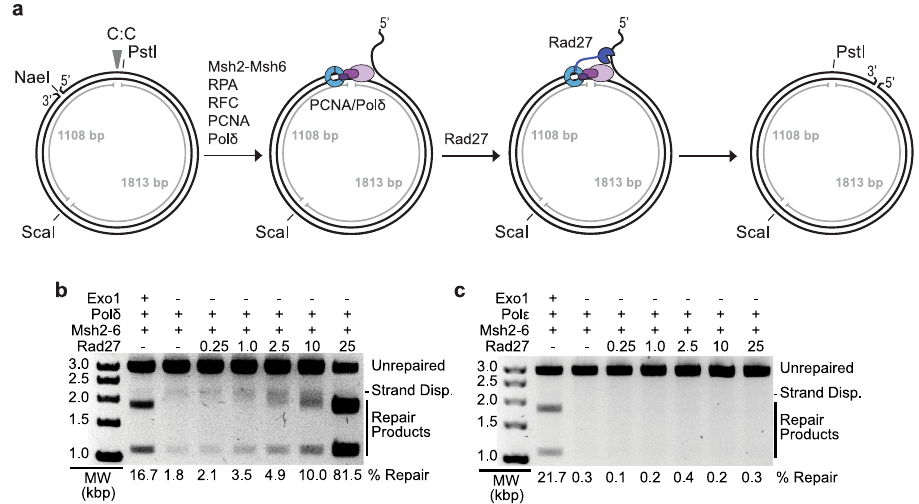
Fig. 2 Reconstitution of 5 ′ nick-directed Rad27-dependent MMR using the NaeI-nicked CC substrate. a Schematic representation of the DNA substrate for the reconstituted repair assays. The substrate has a nick at the NaeI site and the CC mispair, indicated by the arrowhead, disrupts the PstI site. Recruitment of PCNA and DNA polymerase δ to the NaeI nick leads to strand-displacement synthesis and formation of a 5 ’ fl ap which is cleaved by Rad27. Incomplete fl ap cleavage gives rise to slower migrating product bands. b , c Assays of 5 ′ nick-directed repair of the CC substrate, in which different proteins were omitted or substituted as indicated, using either polymerase δ b or polymerase ε c . Amounts in pmole of Rad27 used are indicated for each lane. All reactions also contained PCNA, RFC- Δ 1N, and RPA. Other than Rad27, the amounts of all proteins used in the assays are as listed in the “ Methods ” section. MW, molecular weight markers. The percent repair corresponds to the fraction of all DNA in each individual lane susceptible to PstI cleavage, including those labeled “ strand displacement ” and “ repair products ” . A minimum of three independent experiments was performed.